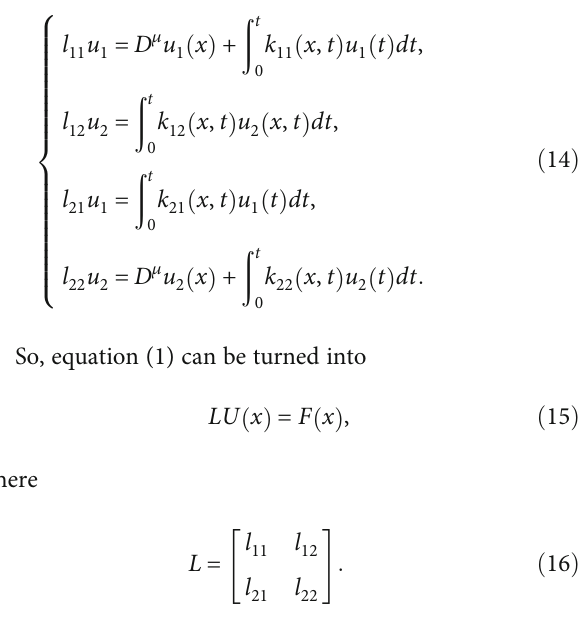
Figure 4: Reproducing kernel R